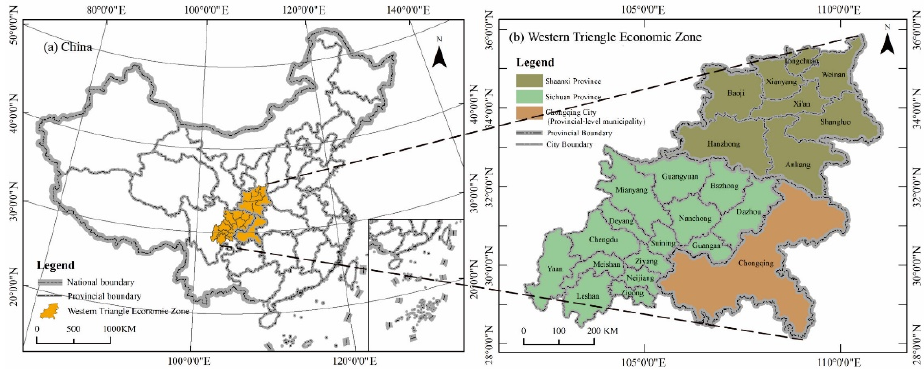
Figure 1. Study Site: ( a ) China; ( b ) Western Triangle Economic Zone in China.